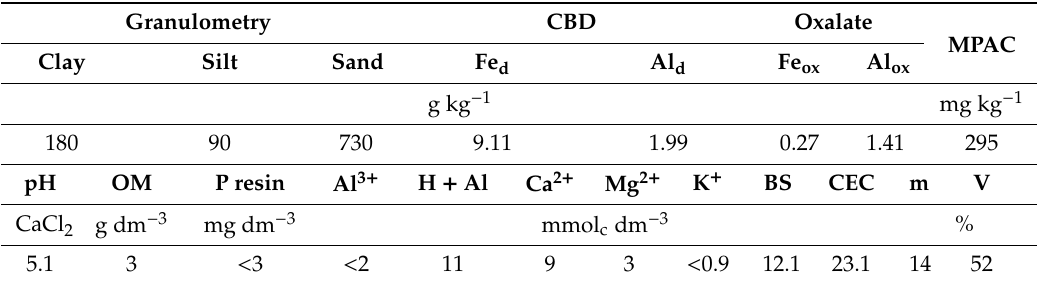
Table 4. Chemical, physical and mineralogical characteristics of the soil used in the column solubilization